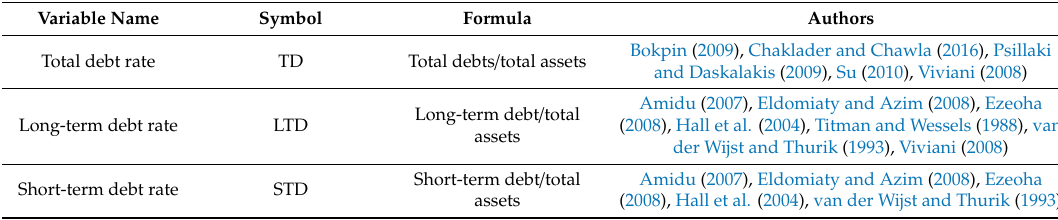
Table 1. Dependent variables included in the empirical